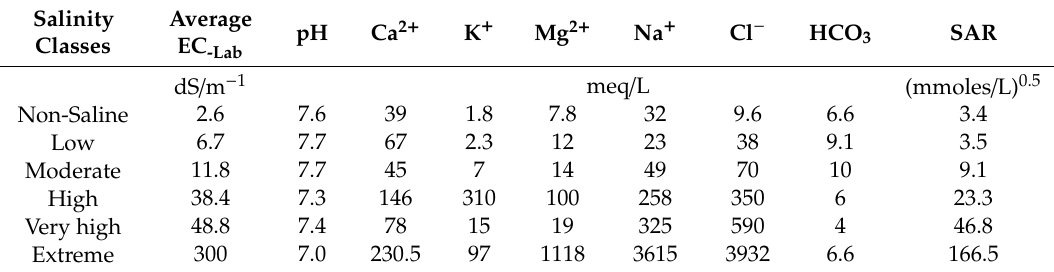
Table 3. Chemical properties of di ff erent soil salinity